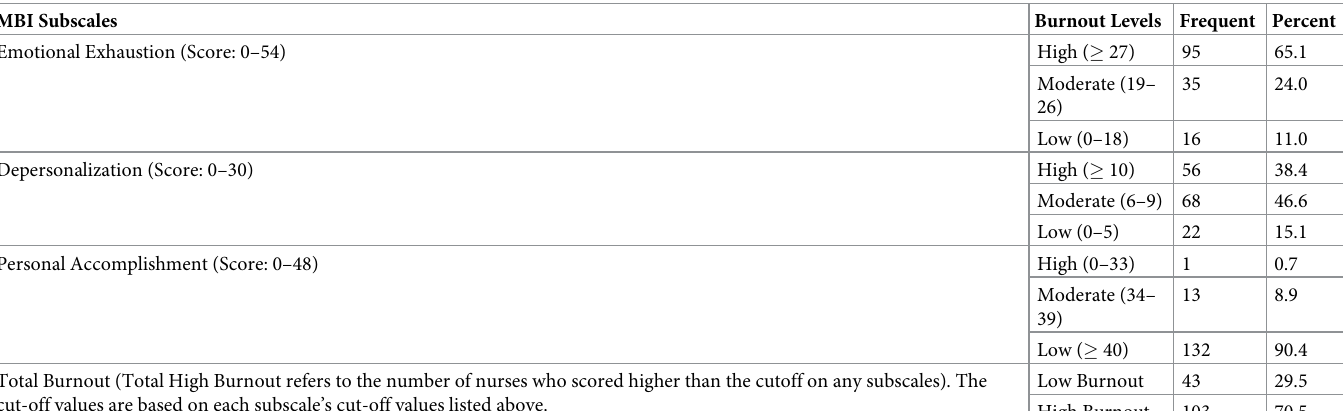
Table 3. Prevalence of burnout among nurses in the sample (N = 146). MBI